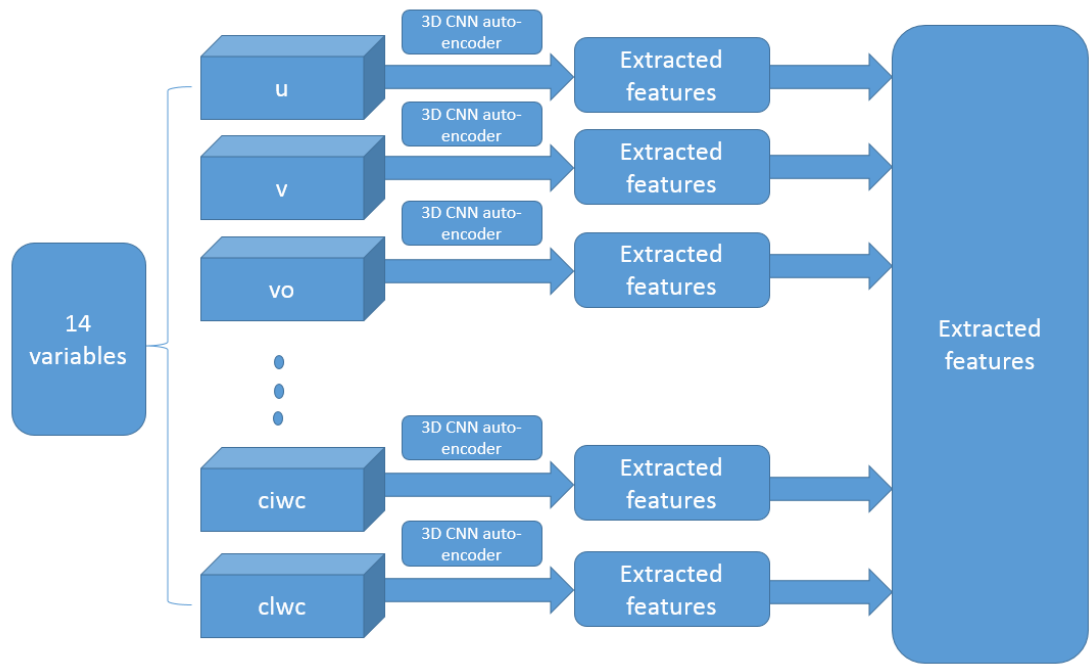
Figure 4. Combined deep learning filters for the 14 variables in ERA-Interim data.